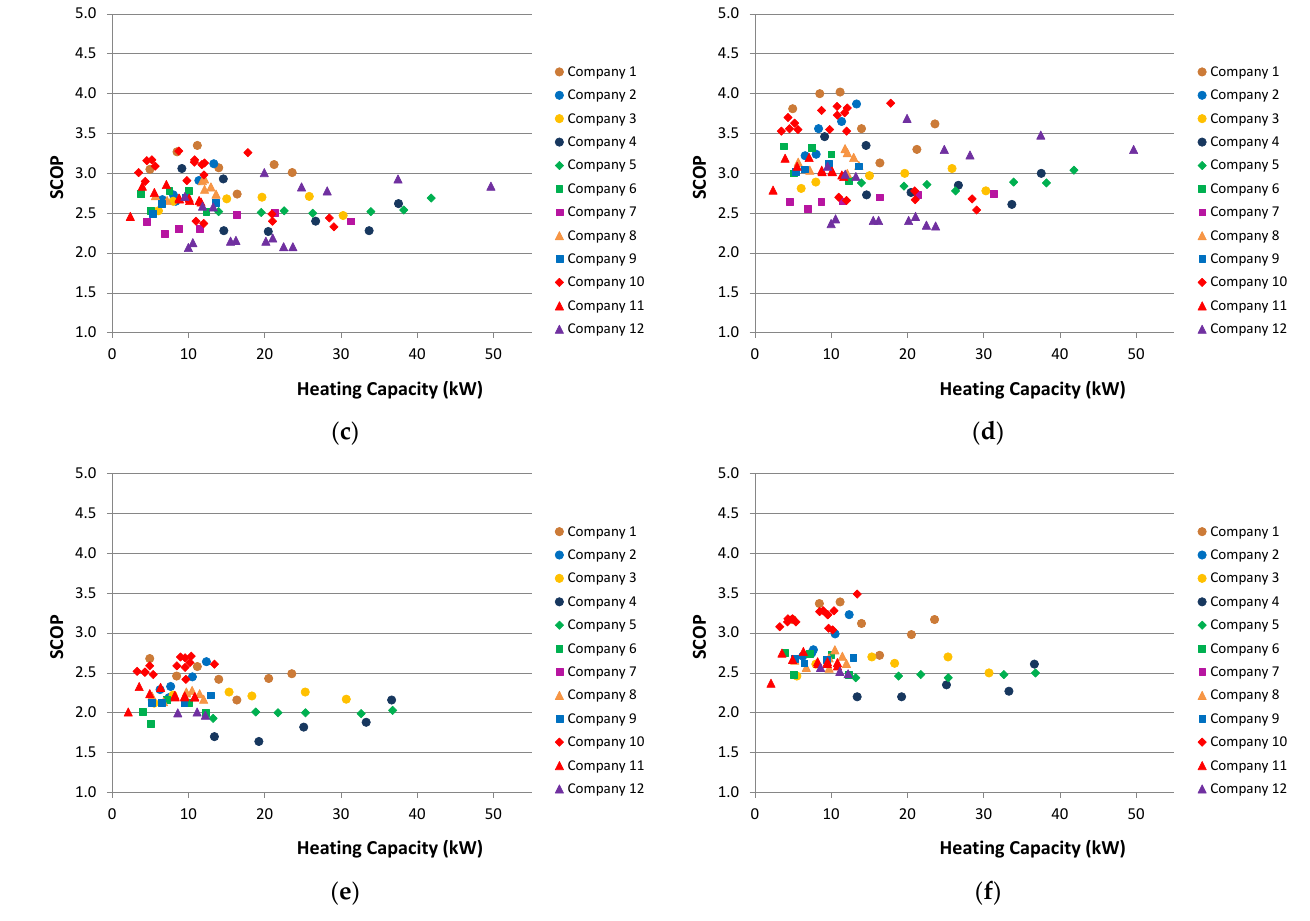
Figure 4. SCOP against HP’s heating capacity for the city of Athens: ( a ) Τ w,outlet = 35 °C—without compensation, ( b ) Τ w,outlet = 35 °C—with compensation, ( c ) Τ w,outlet = 45 °C—without compensation, ( d ) Τ w, outlet = 45 °C—with compensation, ( e ) Τ w,outlet = 55 °C—without compensation, ( f ) Τ w,outlet = 55 °C—with compensation.